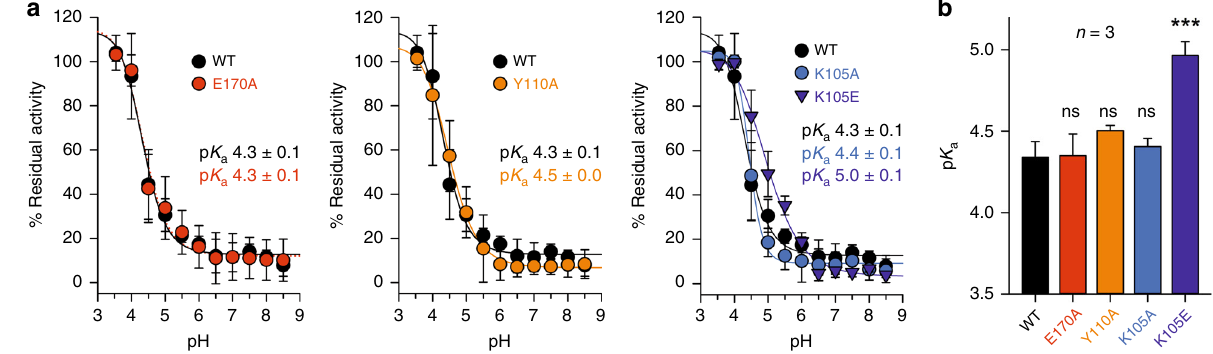
Fig. 3 The side chains of Tyr110 and Lys105 do not affect the p K a -value of the ScGrx7 active site thiol group. Freshly reduced wild-type ScGrx7 (black symbols) and selected mutants (colored symbols) were incubated with 150 µ M iodoacetamide at 23 °C for 180 s in a three-buffer system at pH 3.5 – 8.5. Residual activities were measured in a standard HEDS assay and normalized against mock controls that were incubated in parallel without iodoacetamide. a Data for wild-type ScGrx7 (WT) and the mutants E170A, Y110A, K105A, and K105E. Samples containing iodoacetamide were apparently more stable at lower pH values than the mock controls resulting in residual activities slightly above 100%. The p K a values from the sigmoidal fi ts are indicated. Data points and error bars represent the mean ± s.d. of three independent experiments. b Summary and statistical analyses of the p K a values from panel ( a ). Sigmoidal fi ts using the four parameter Hill function and P values from one way ANOVA analyses followed by a Holm – Sidak test were calculated in SigmaPlot 13 ( P > 0.05: ns; P ≤ 0.001: ***). Source data are provided as a Source Data fi